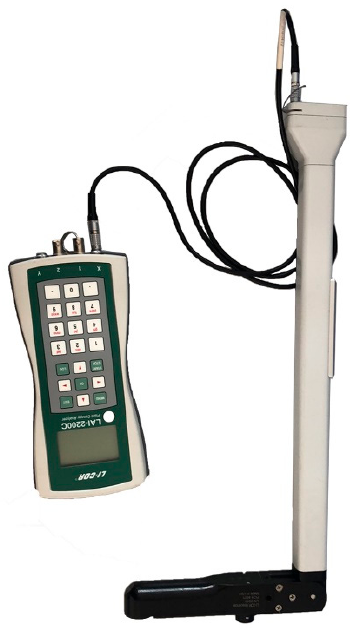
Figure 4. LAI-2200C plant canopy